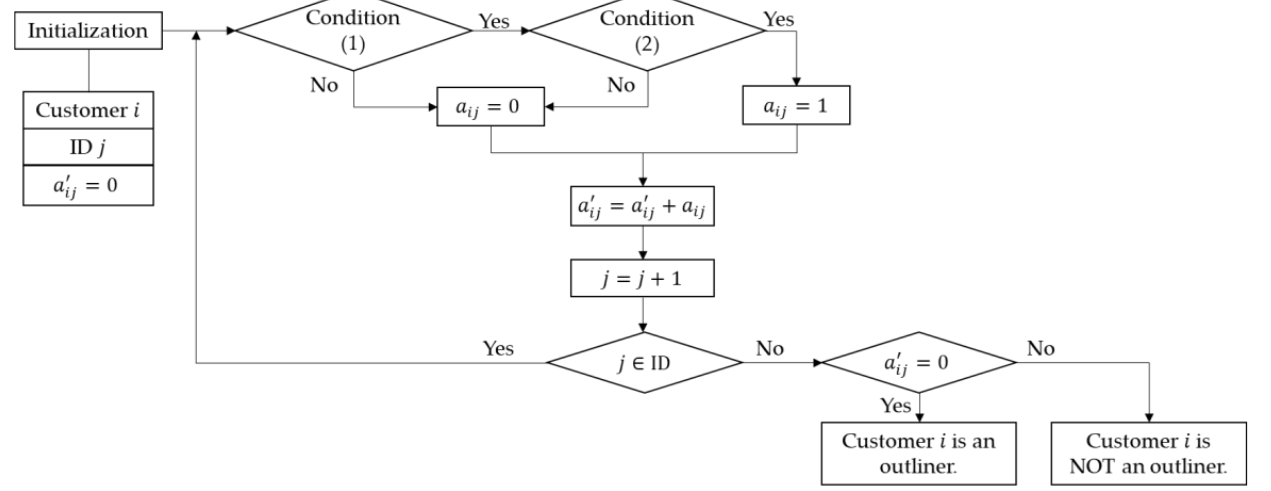
Figure 4. The process to determine whether a customer is an outliner. After determining the subsets of customers to be served directly by CVs or by EVs,